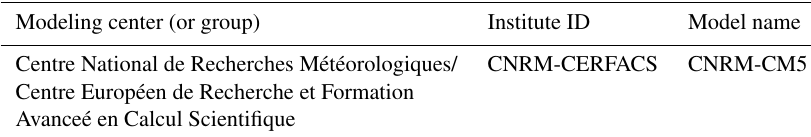
Table A1. CMIP5 models employed in the present study.